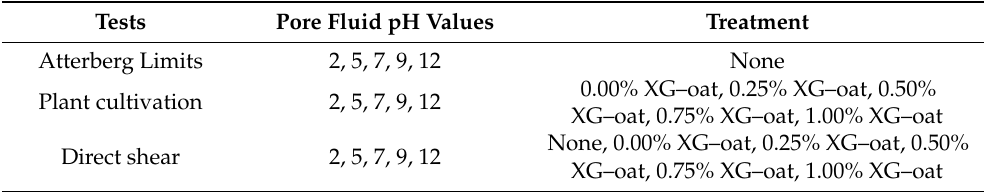
Table 1. Soil and treatment conditions for Atterberg limits, plant cultivation, and direct shear.